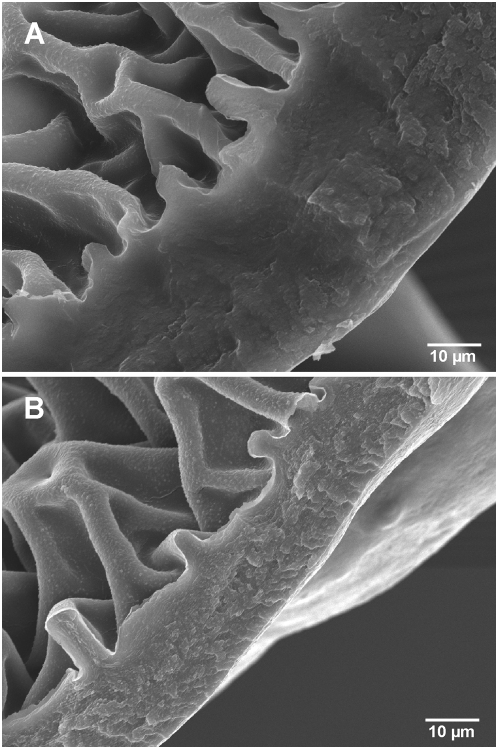
The cuticle of T. infestans fourth-instar nymphs.Scanning electron micrograph (SEM) of a transversal cut of the second tergite of pyrethroid-resistant (A) and pyrethroid-susceptible (B) bugs. The cuticle width was estimated in 32.1±5.9 µm and 17.8±5.4 µm respectively, P<0.0001. Magnification: 1,400×.